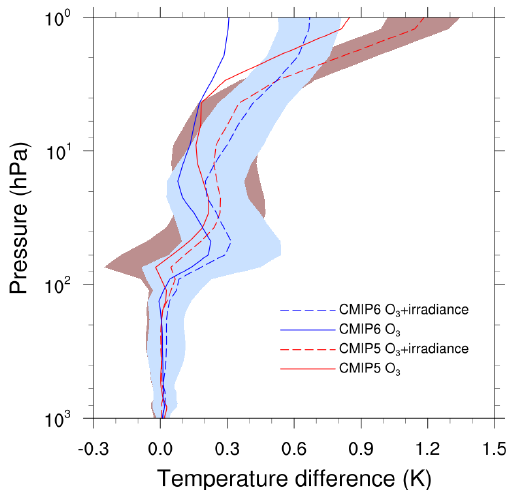
Figure 9. Average tropical (30 ◦ S–30 ◦ N) solar cycle (max–min) temperature anomalies as simulated by ECHAM6.3. Anomalies have been calculated between four sensitivity experiments repre- senting different solar maximum conditions and a reference exper- iment representing solar minimum conditions. The sensitivity ex- periments are performed by prescribing (red solid) SOR from the recommended Extended CMIP5 ozone database; (red dashed) rec- ommended SOR and solar spectral irradiance anomalies for CMIP5; (blue solid) historical SOR from the recommended CMIP6 ozone database; and (blue dashed) recommended SOR and solar spectral irradiance anomalies for CMIP6. The shaded regions denote 2.5– 97.5% confidence intervals on the combined forcing